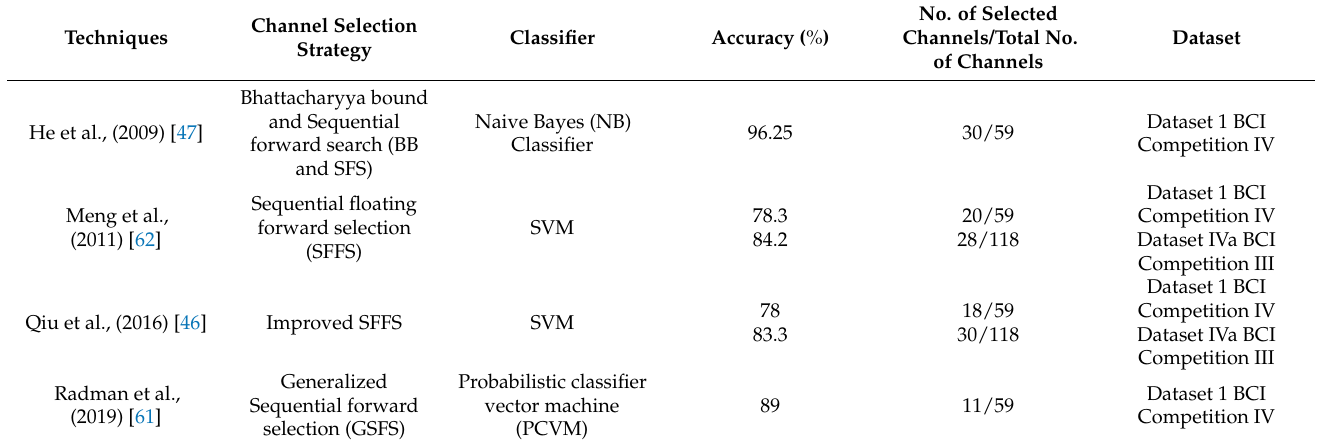
Table 4. Sequential-based techniques for the selection of motor imagery EEG channel